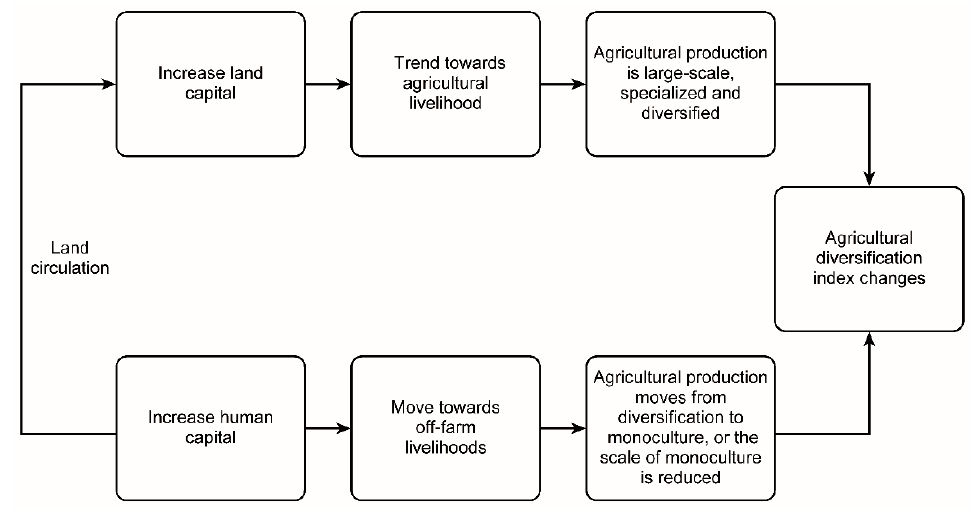
Figure 2. Impact of farmers’ variable livelihoods on agricultural diversification.